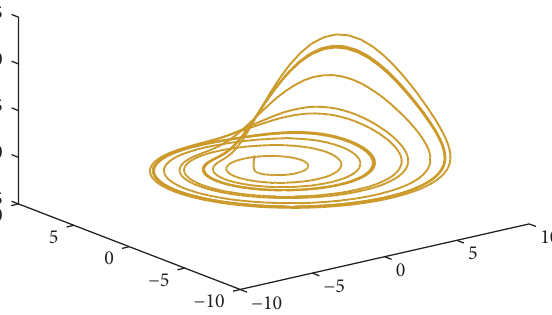
Figure 11: Bernoulli distribution.